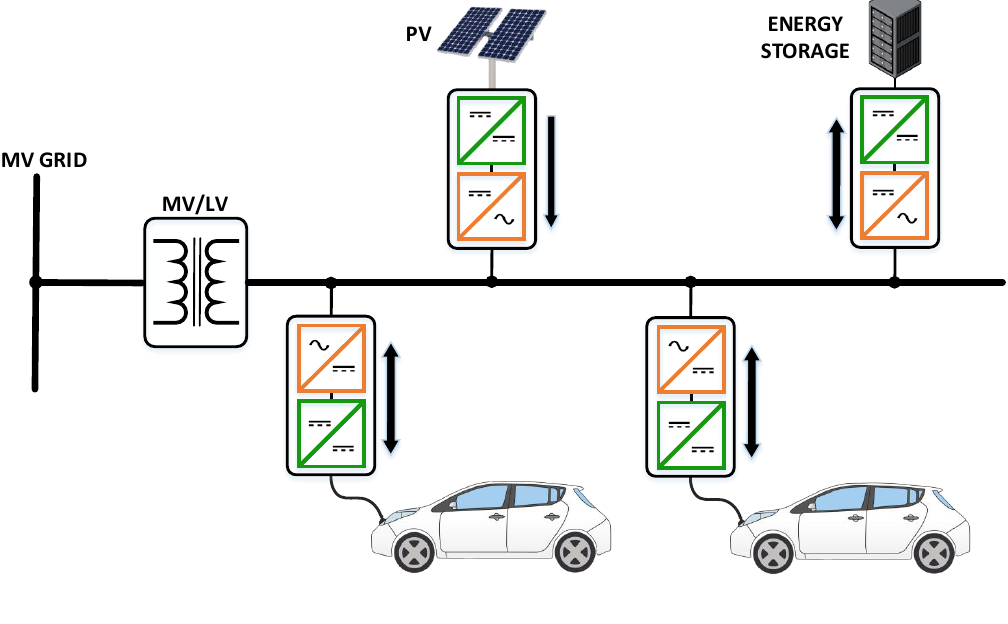
Figure 6. AC coupled charging